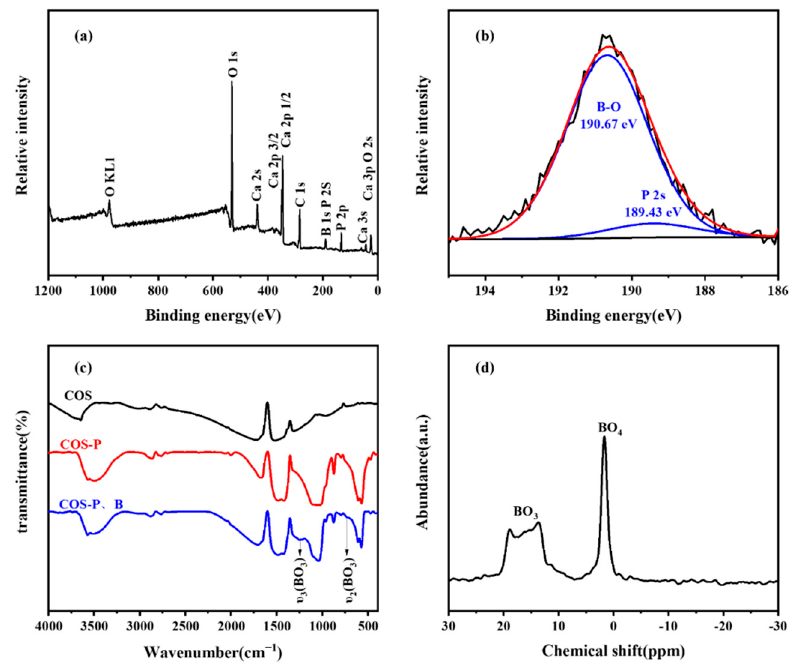
Figure 7. XPS wide spectrum ( a ), XPS spectra of P ( b ), FT-IR spectra ( c ), and 11 B-NMR spectrum ( d ) of COS after reaction.